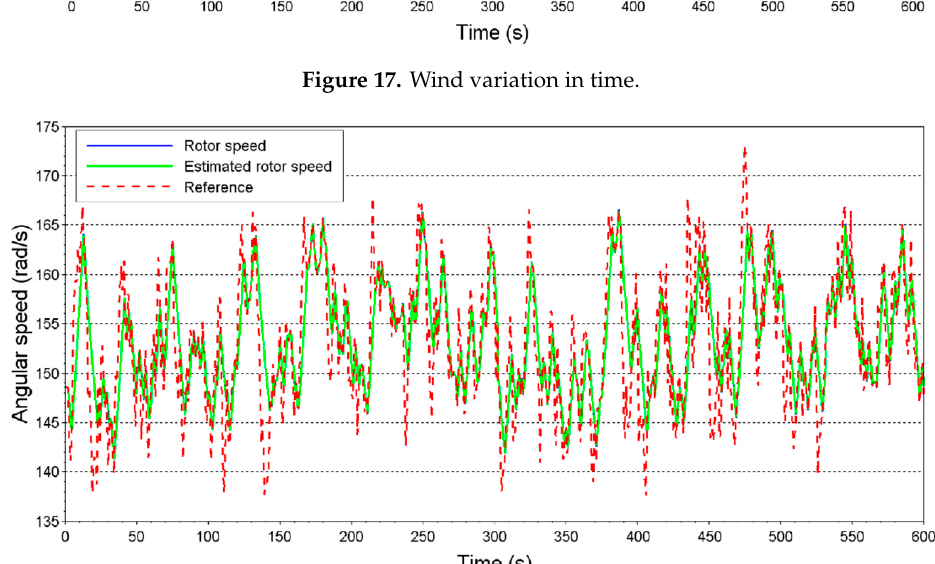
Figure 18. Rotor speed variation to follow its reference.